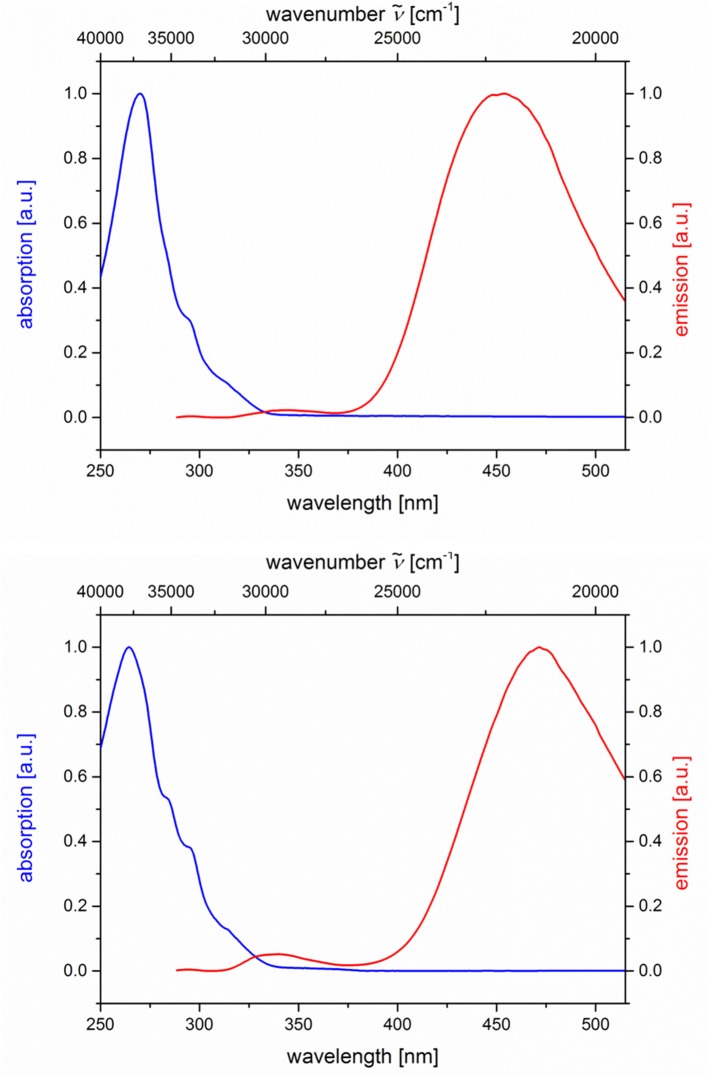
Normalized absorption (blue lines) and emission (red lines) spectra of compounds 5g (top) and 5h (bottom) (recorded in CH2Cl2 (chromasolv), T = 298 K, λexc = 268 nm).